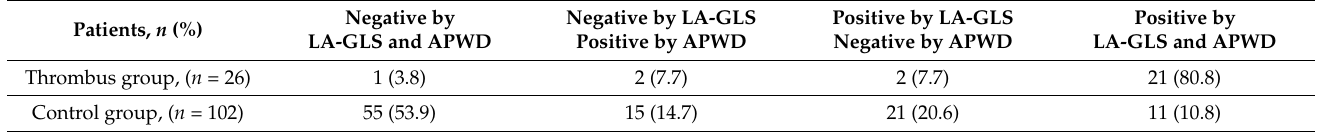
Figure 4. Diagnostic value of LA-GLS and APWD for thrombus identification. ( A , B ) show the ROC curves for presence of thrombus for each method. The diagnostic value of the combination of LA-GLS and APWD is illustrated in ( C ). Based on coordinates of ROC curve, a threshold of 17.45% and 165 ms were determined as corresponding thresholds. ( D ) displays the efficacy of each threshold in identifying patients with thrombus. Green and orange bars stand for the percentage of patients that were diagnosed as positive or negative for thrombus based on the corresponding threshold, respectively. ( E ) illustrates the results of thrombus identification by combined thresholds of LA-GLS and APWD, the percentage of patients is illustrated in bar with different colors (orange bars refer to patients who are diagnosed as positive for LAA-thrombus by both LA-GLS and APWD thresholds, green bars refer to patients who are diagnosed as negative by both thresholds, light orange bars refer to patients with one positive diagnosis for LAA-thrombus by APWD and one negative diagnosis by LA-GLS, and light green bars refer to patients with positive diagnosis by LA-GLS and negative diagnosis by APWD. LA-GLS, left atrial global longitudinal strain; APWD, amplified sinus-p-wave duration; ROC curve, receiver operating characteristic curve; LAA, left atrial appendage; AUC, area under the curve; CI, confidence interval. Table 4. Combination of LA-GLS threshold and APWD threshold for LAA-thrombus